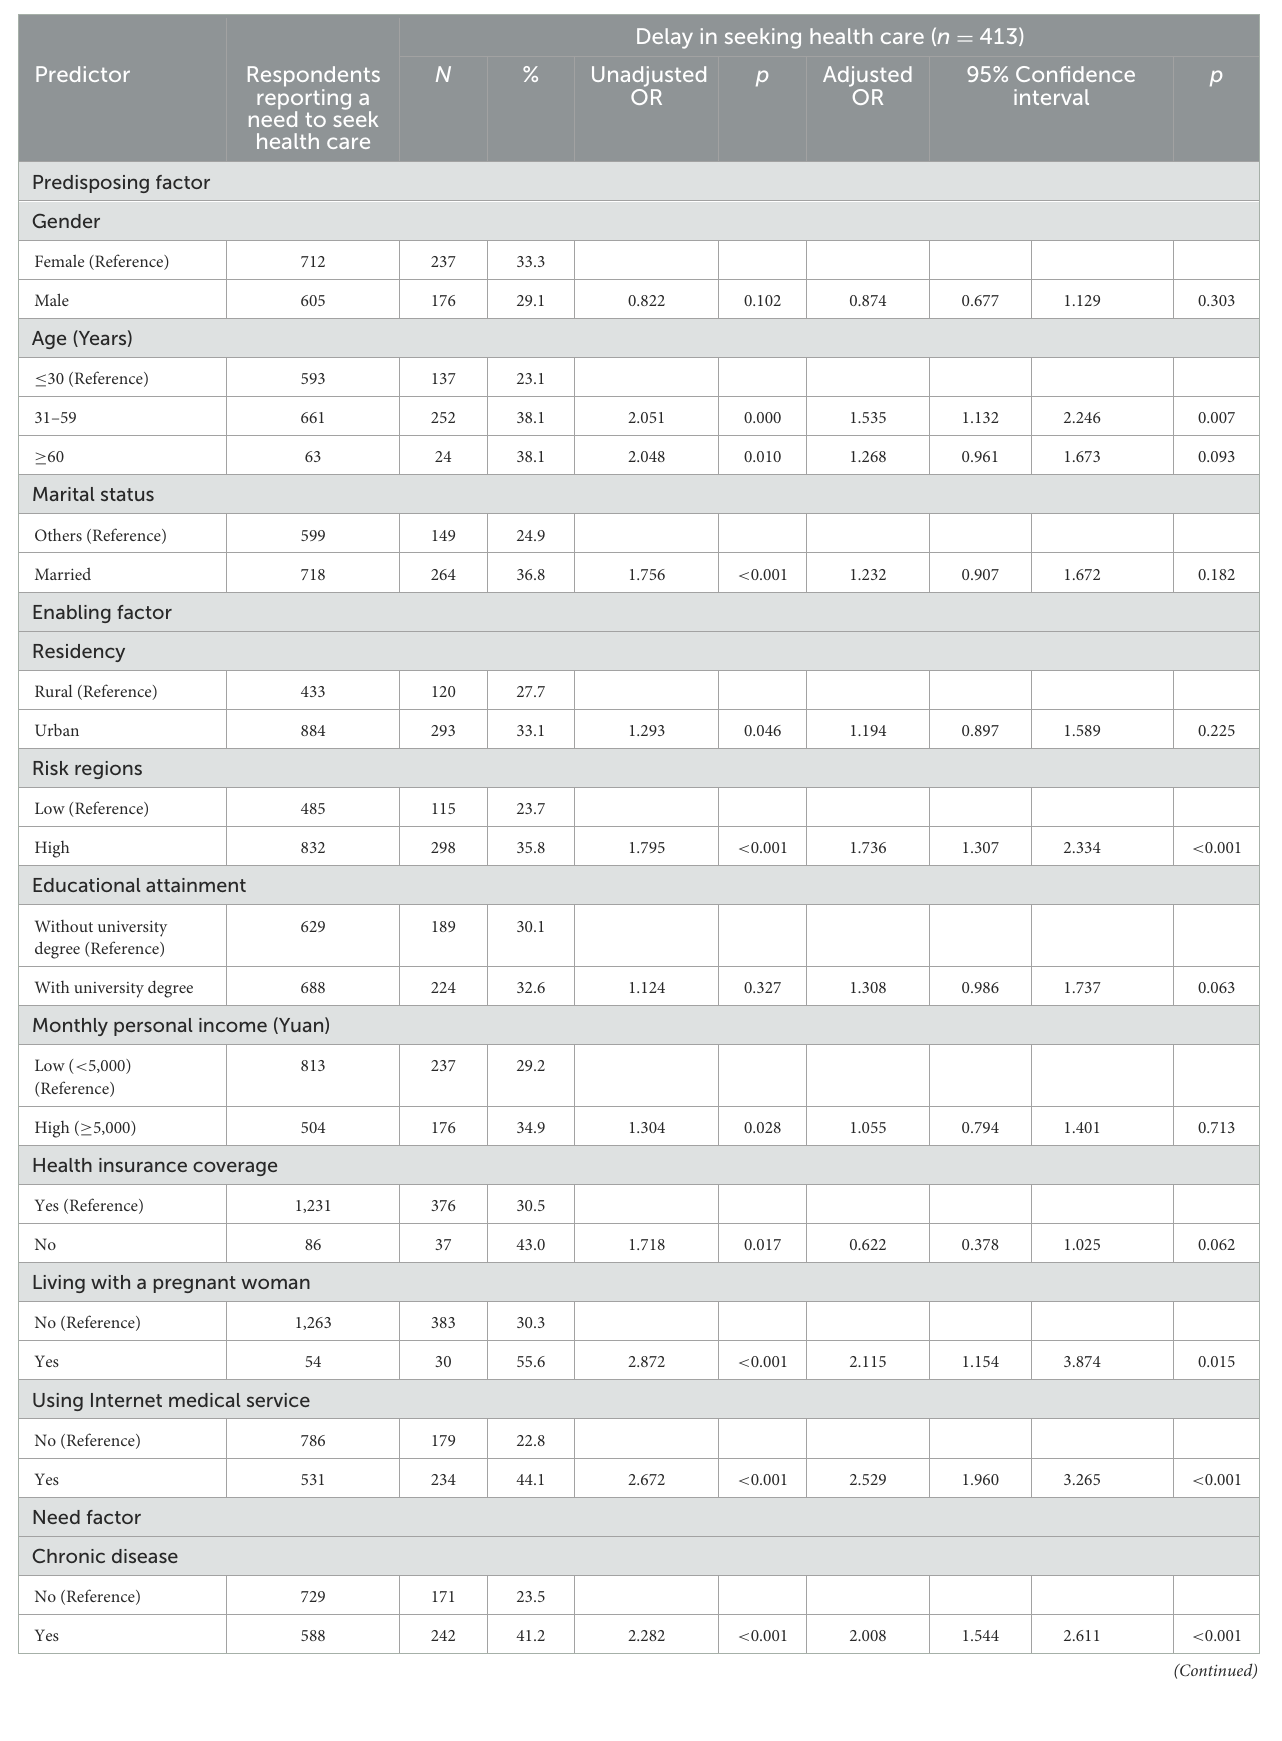
TABLE 2 Delay in seeking health care in study participants with different characteristics ( n =